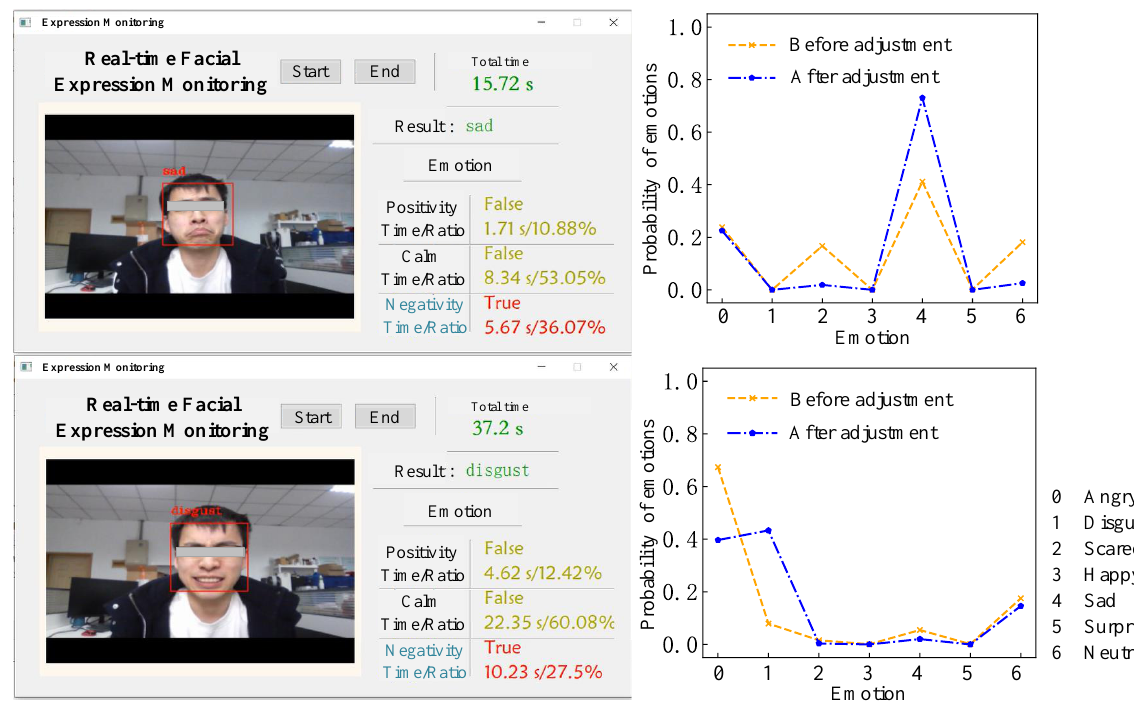
Figure 8. Expressions of sadness and disgust of Subject